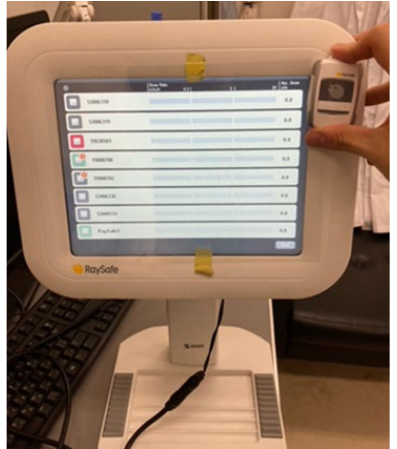
Figure 2. A schematic of the i3 system (left: base station with 10.4-inch display; right: i3 dosimeter sensor). The system comprises a wireless i3 sensor (solid-state semiconductor detector) that trans- mits the scattered-radiation dose to the base station. The i3 sensor is small (40 × 58 mm, 34 g) and thus easy to carry during